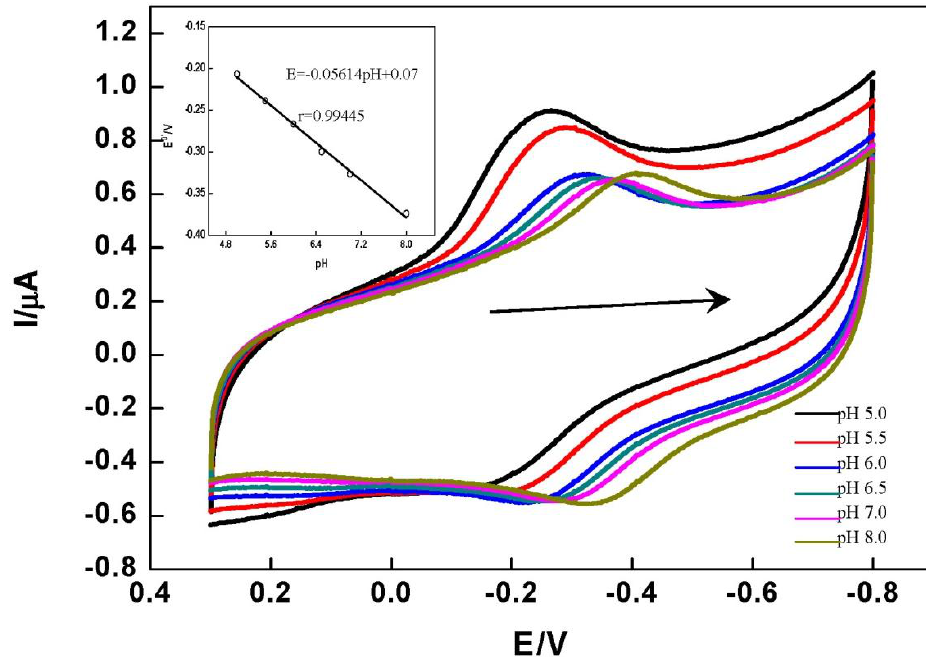
Figure 5. Cyclic voltammograms of DNA/chitosan/Fe phosphate buffers (from left to right 5.0, 5.5, 6.0, 6.5, 7.0, 8.0). Scan rate: 150 mV·s −1 . Inset: the plot of E 0 ′ of HRP vs. pH of the